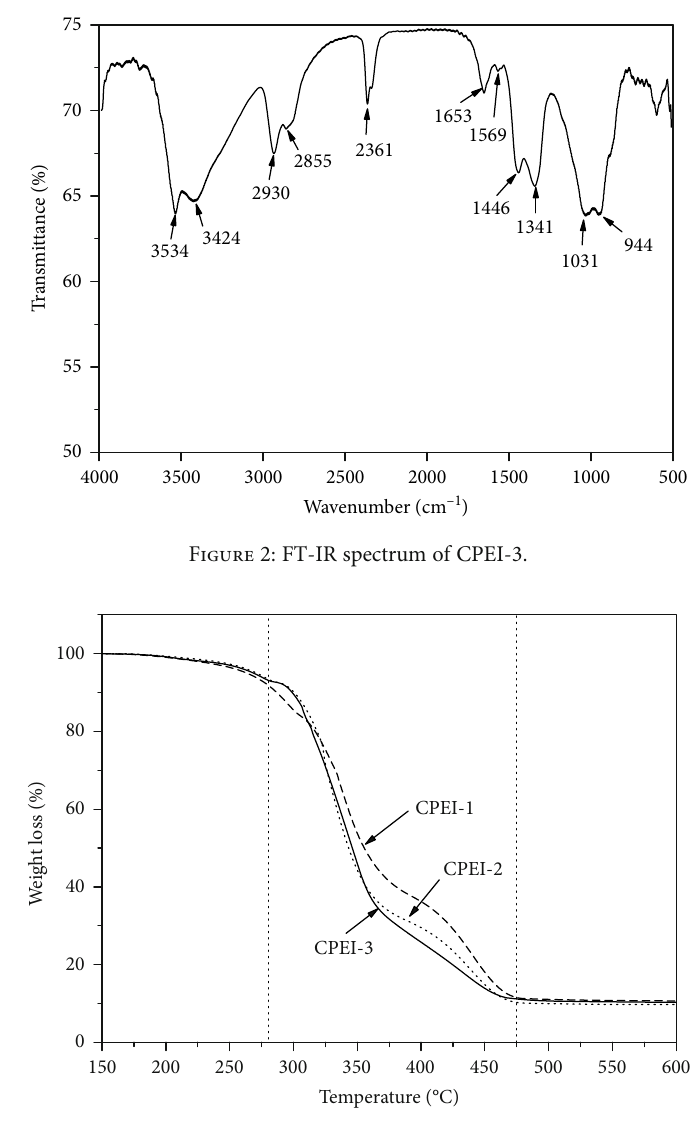
Figure 3: TGA curves of CPEI-1, CPEI-2, and